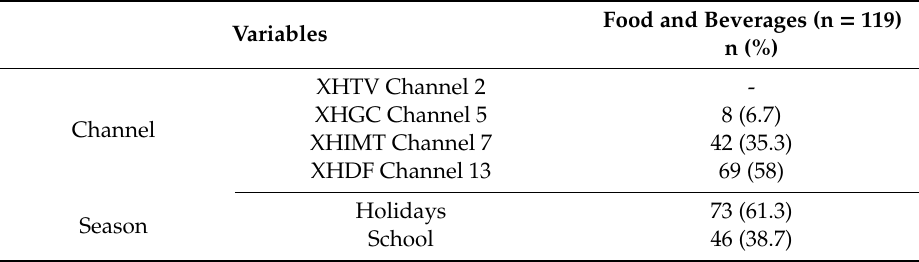
Table 3. Percentage of food and beverages advertised by product placement on Mexican public television, broadcast from 19 to 22